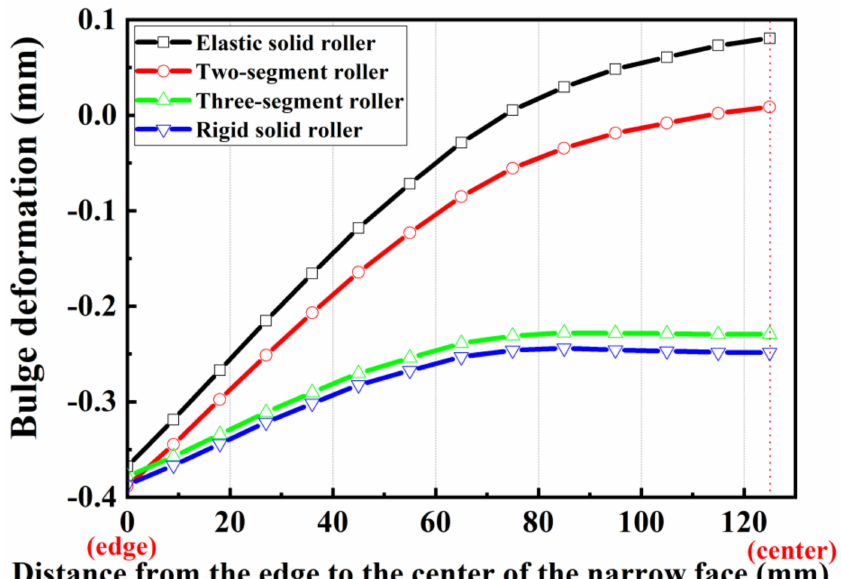
Figure 8. Bulge deformation of the slab on the narrow side with different casting